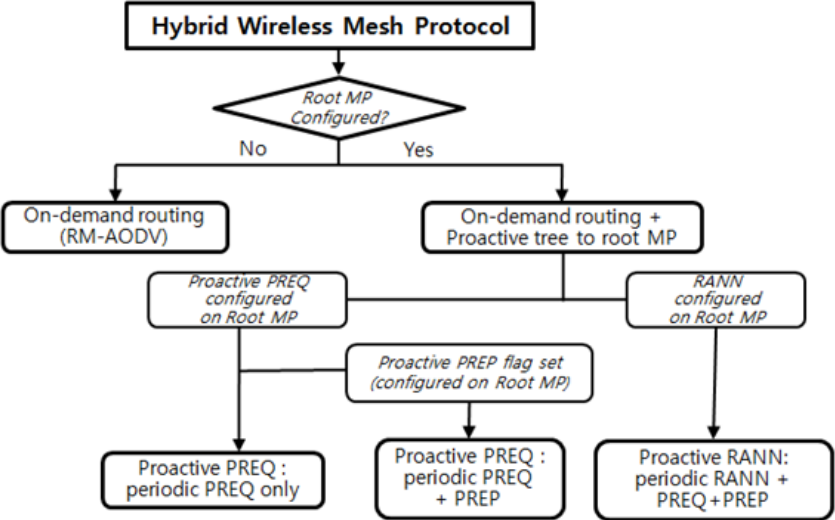
Figure 6. Configuration cases for HWMP